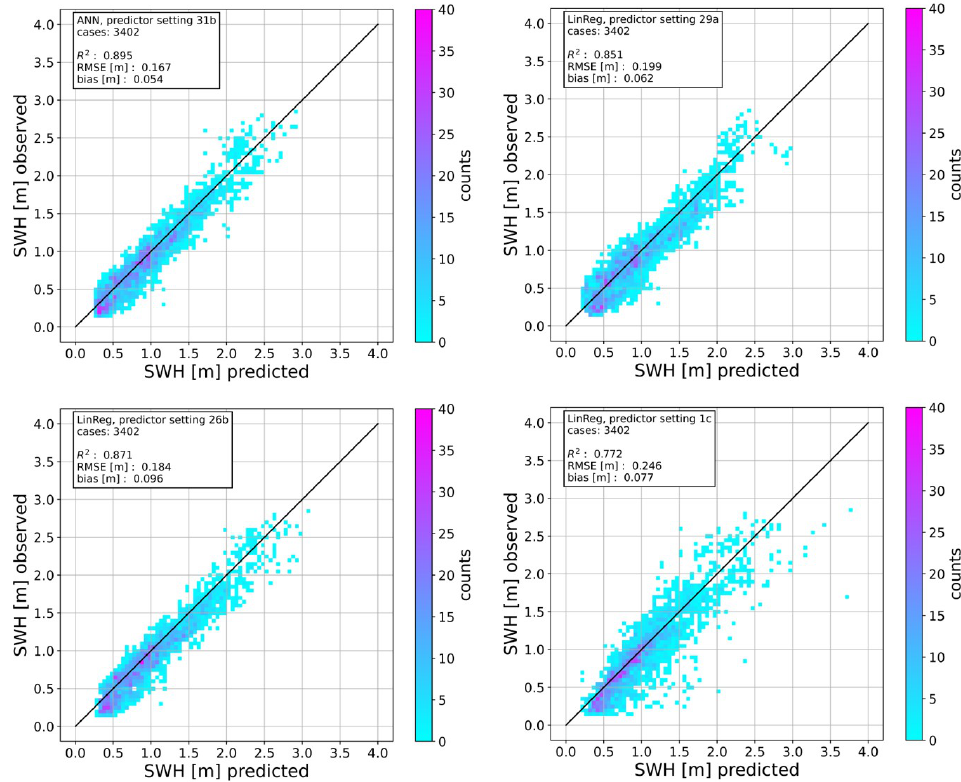
Figure 10. Observed SWH plotted against predicted SWH for the whole testing dataset for four different combinations of model and predictor setting stated in the individual plots. The number of regression cases used and measures for the quality of the estimations are also